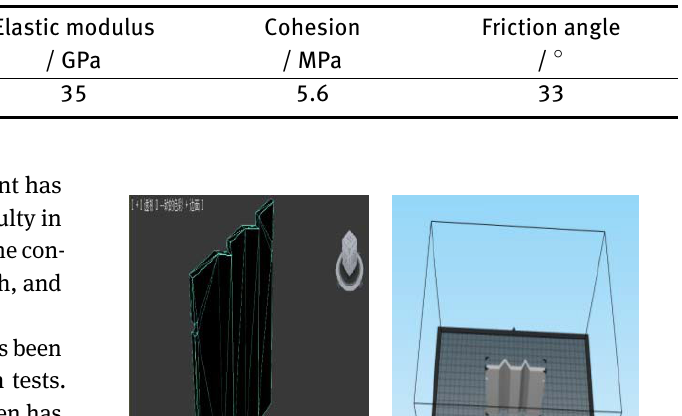
Elastic modulus / GPa